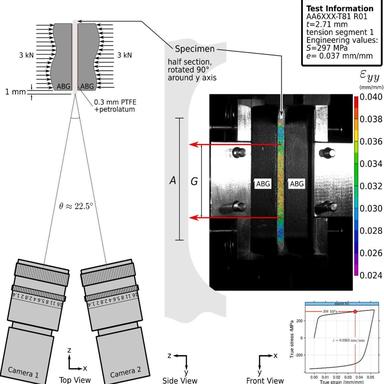
A schematic of the DIC strain measurement system used for tension-compression testing, along with typical image (from Camera 1 perspective) with DIC true strain contour map on an image of the specimen plus anti-buckling guides. The specimen outline in the side view image shows the relative positions of the gauge length on the same scale as the specimen in the front view. The plot in the lower right corner shows the point on the stress-strain curve that corresponds to the strain map.